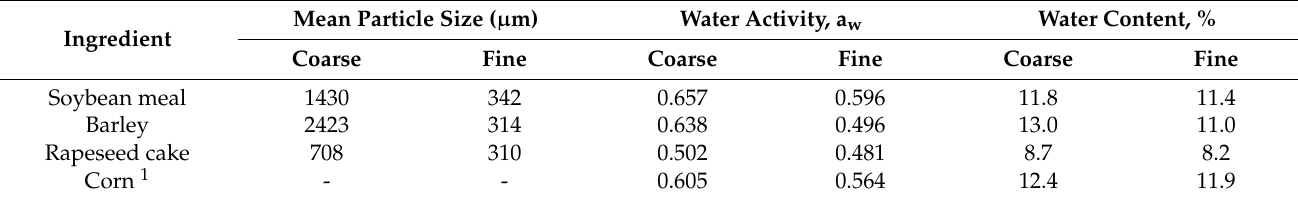
Table 2. Water activity and content in fine and coarse milled feed ingredients (adapted from